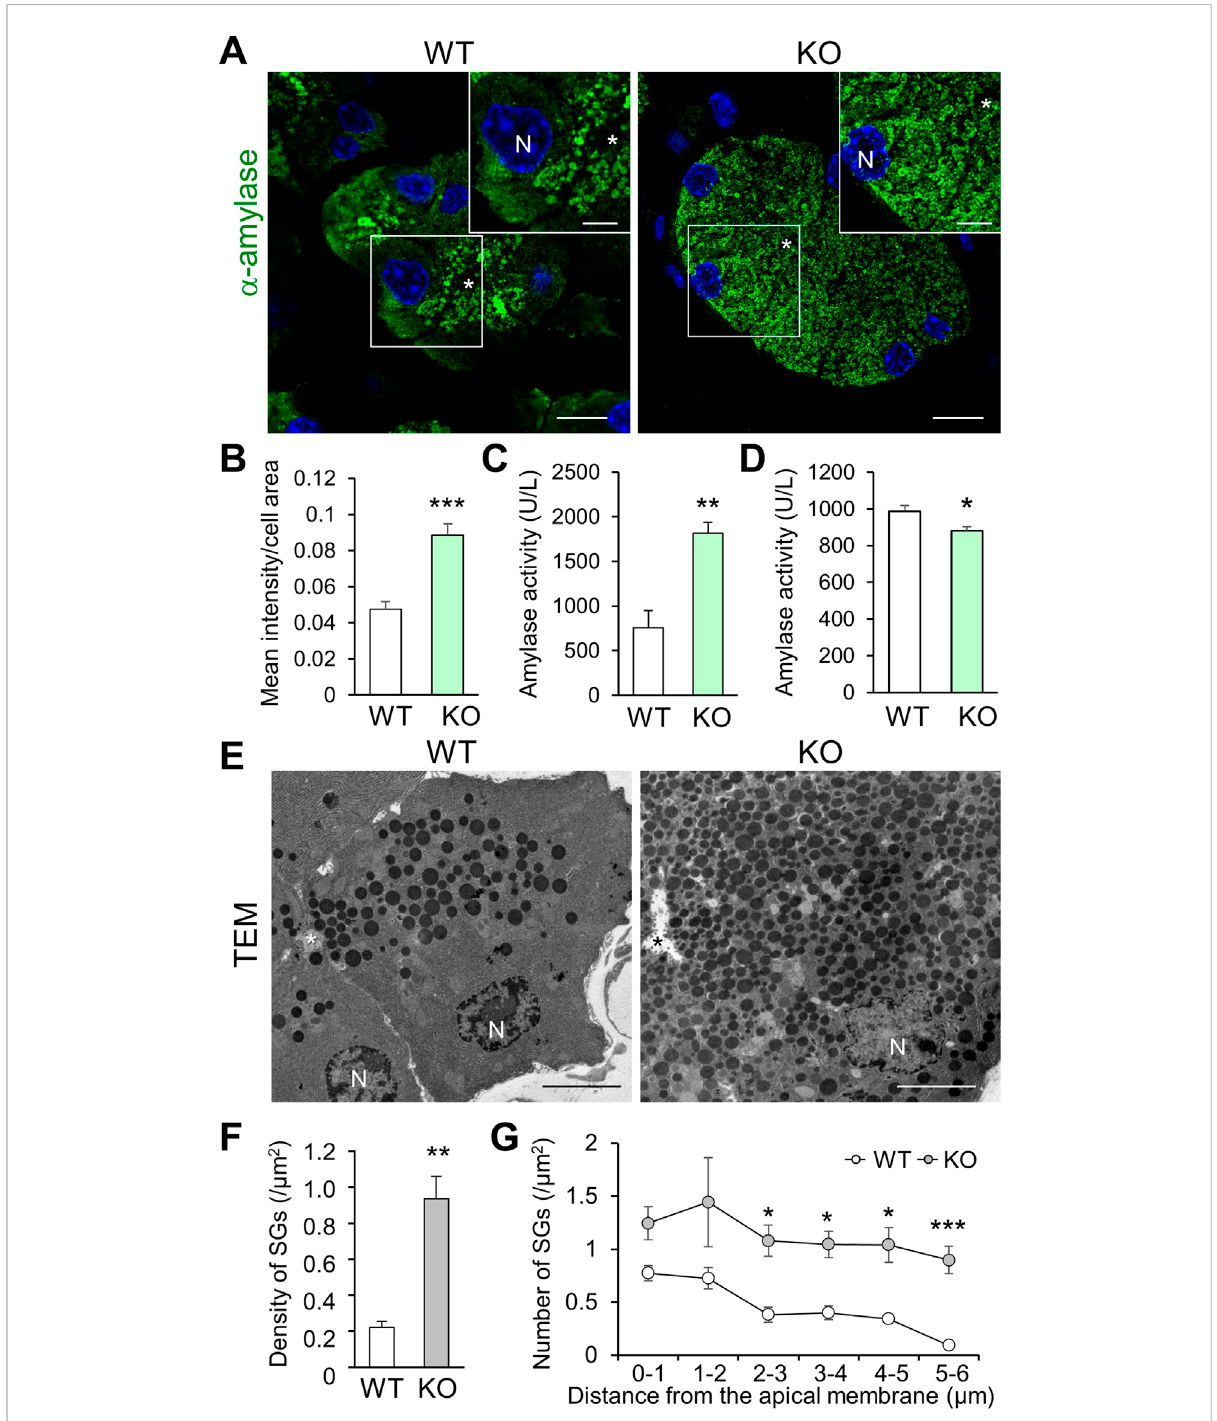
FIGURE 3 Cadps2- KO mice exhibit accumulation of α -amylase and secretory granules in the cytoplasm of pancreatic acinar cells. (A) , α -Amylase ( green ) immunohistochemistry in the exocrine pancreas of 1-month-old WT and KO mice. The insetin the top right corner represents a magni fi ed image of the square area shown in each panel. Asterisks , the acinar lumen. N, DAPI ( blue )-positive nucleus. Scale bars, 10 μ m; 5 μ m in the inset. (B) , Signal intensity ofcytoplasmic α -amylaseimmunoreactivity. Tendifferentrandomlychosenregions ofinterest (ROI)(127×127 μ m)wereanalyzedfor each genotype (WT: n = 5, KO: n = 4). Mean intensity/area ±SEM: WT, 0.048 ± 0.004; KO 0.089 ± 0.006. Student ’ s t -test: *** p = 0.00053. (C,D) , Enzymaticactivityof α -amylase.Oneunit(U)wasde fi nedastheamountofamylasethatcleavessubstrateethylidene-pNP-G7togenerate1.0 µmole of p -nitrophenol per min at 25 ° C. (C) , Enzymatic activity of α -amylase in pancreatic protein extracts of 10-week-old WT and KO mice (U/L: mean ±